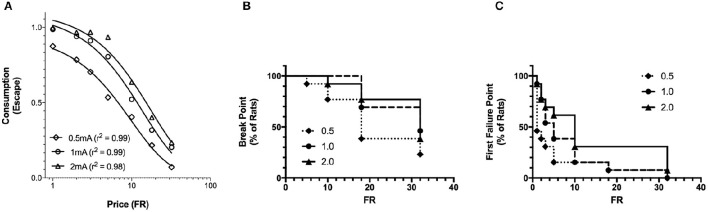
Exponentiated and break point analysis of increasing footshock intensity. (A) A composite demand curve was generated by fitting the exponentiated demand equation (Equation 2) to mean consumption at each shock intensity. The symbols represent successful escapes and the lines represent the best fit demand curves for each shock intensity (diamonds = 0.5 mA, circles = 1.0 mA, and triangles = 2.0 mA). Q0 at 1.0 and 2.0 mA differed from 0.5 mA, but did not differ from each other. α differed at all 3 stimulus intensities. The fits (r2) of the exponentiated and exponential demand equation were similar. (B) For each FR, the proportion of rats reaching their break point is represented by a reduction in the survival curve (survival is equivalent to the rats completing at least one trial for the FR). Differences in break point were not observed between shock intensities. (C) For each FR, the proportion of rats reaching their first failure point is represented by a reduction in the survival curve (survival equals rats successfully completing all trials for the FR). The first failure point was different across shock intensities, significantly differing between 0.5 and 2.0 mA, but not elsewhere.